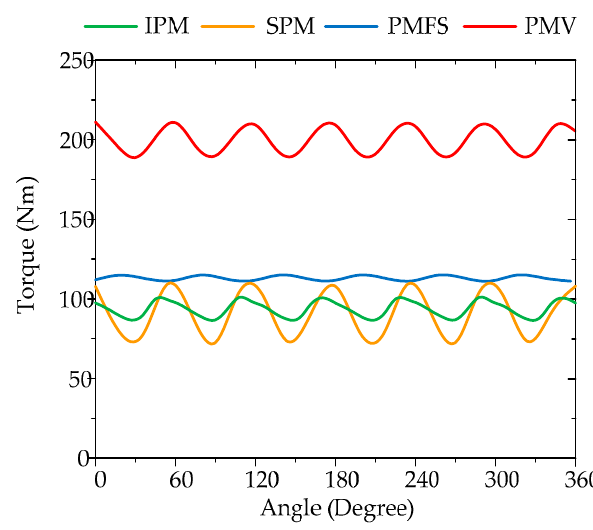
Figure 8. Steady torque of proposed six-phase outer-rotor PM machines.